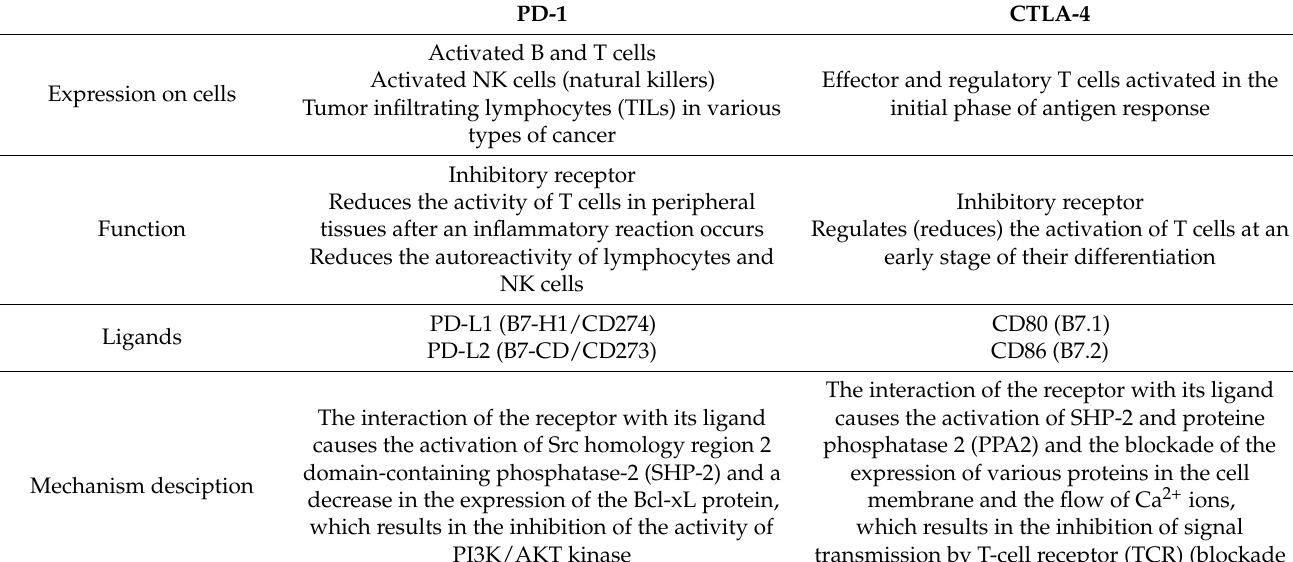
Table 2. Comparison of immune